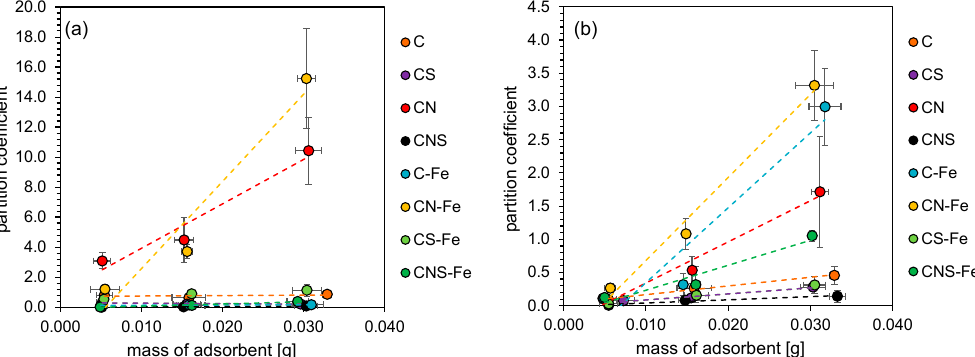
Figure 2. The partition coefficient of E. coli ( a ) and B. cereus ( b ) after sorption at different masses of doped carbon.